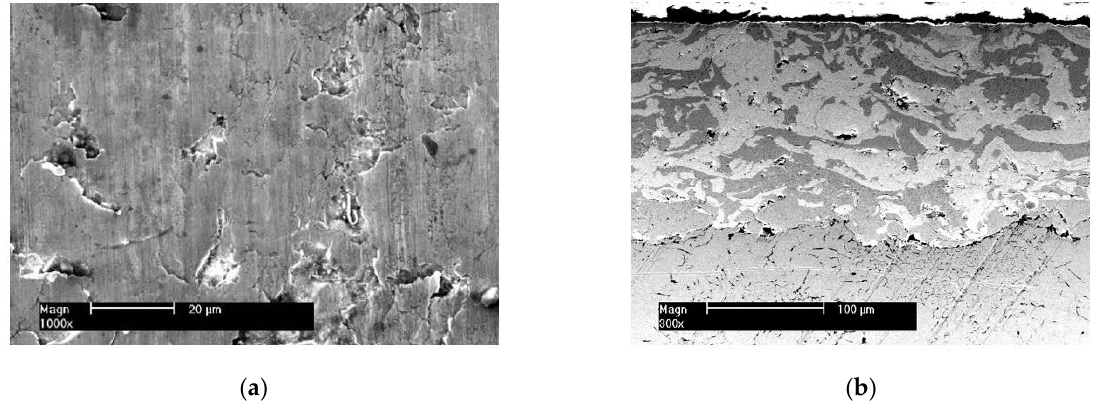
Figure 3. Surface ( a ) and cross-section ( b ) morphology of the piston ring with the NCM coating.